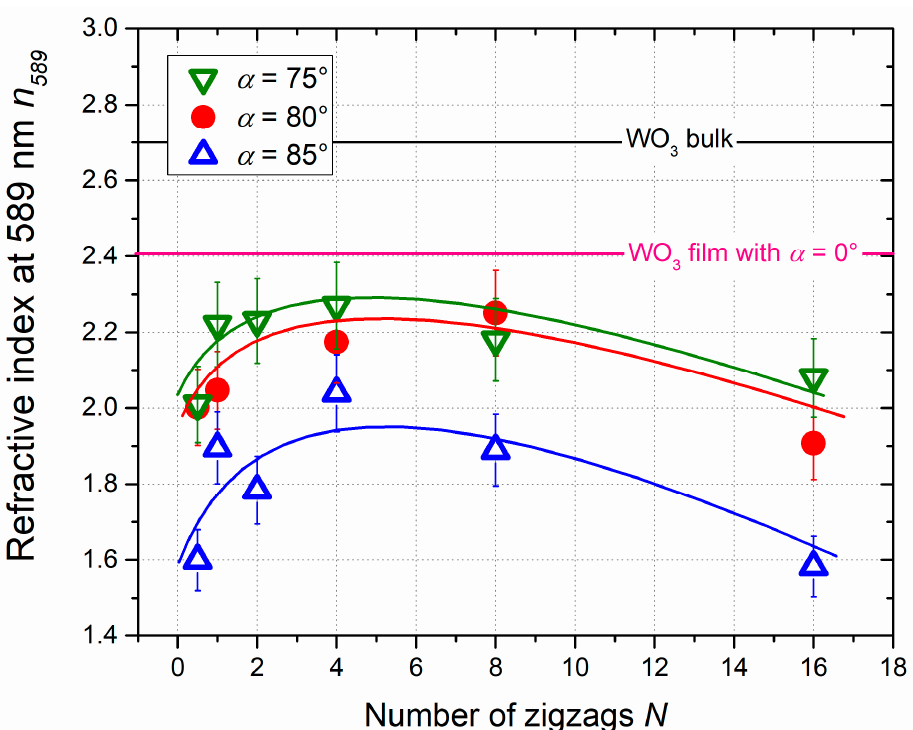
Figure 7. Refractive index at 589 nm of WO 3 films vs. number of zigzags N . All films were sputter- deposited with a duty cycle dc = 80% of the pulsing period P and for tilt angles α = 75°, 80°, and 85°. Refractive index of bulk WO 3 material and standard WO 3 film ( α = 0° and without oxygen pulsing, i.e., dc = 100% of the pulsing period P ) is also indicated. The lines are a guide to the eye.